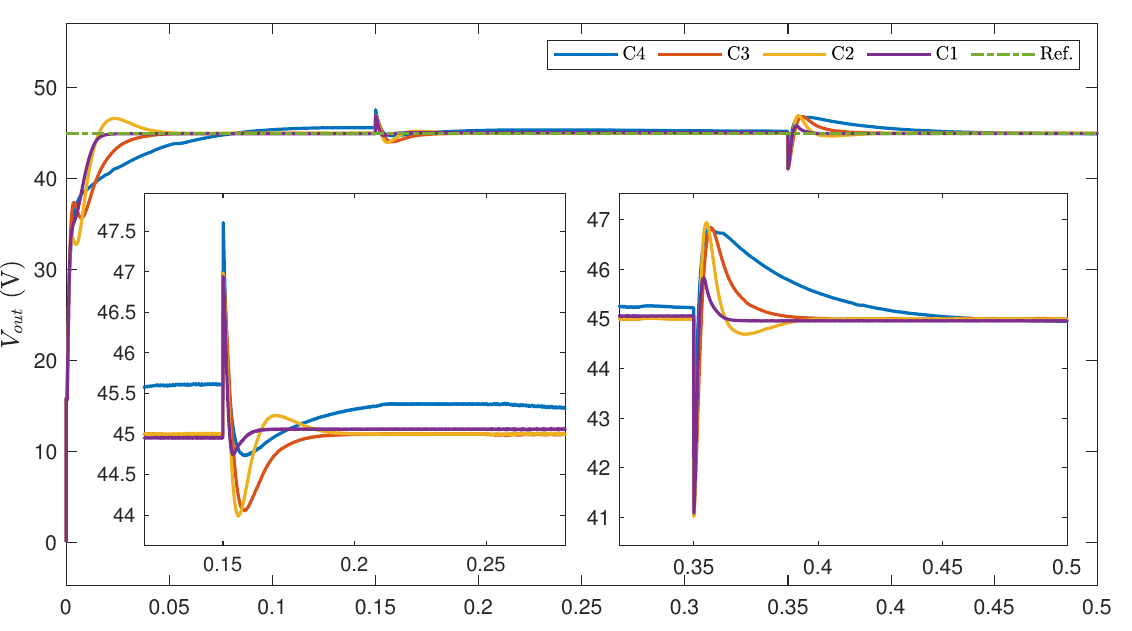
Figure 6. The output voltages of the FIBC under the four controllers in the case of input voltage